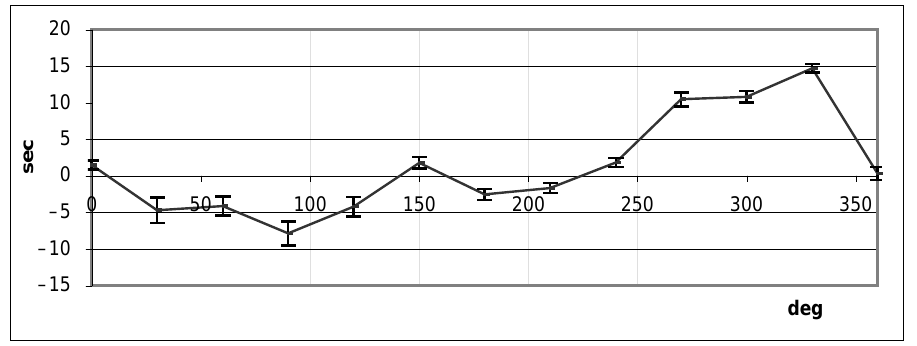
Fig 5. Graph of the tacheometer readings with uncertainty (20 02